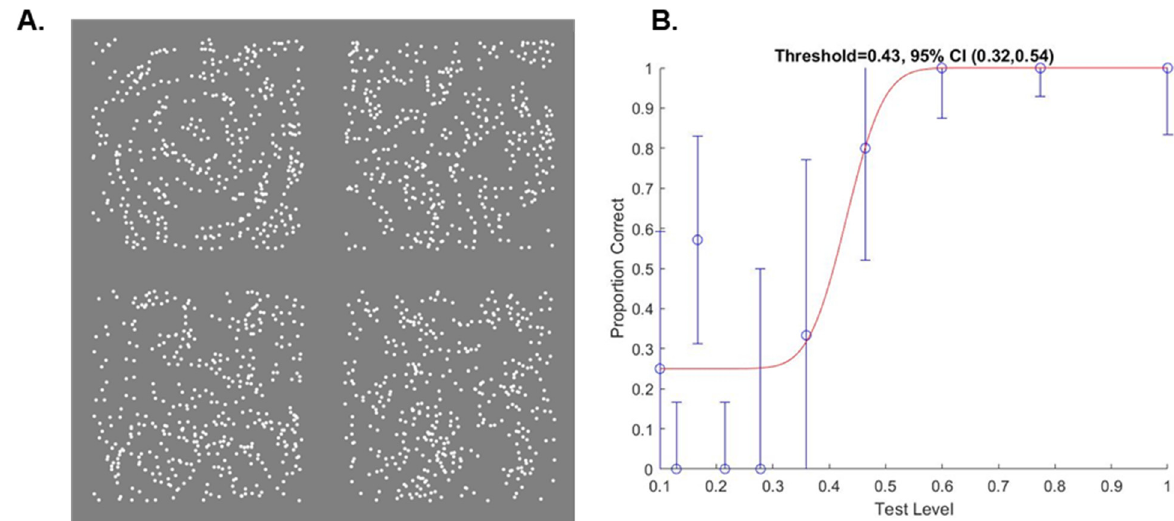
Figure 2. Example stimulus and psychometric function from the glass pattern task. ( A ) Each stimulus contained four quadrants, each of which contained 200 dipoles. The orientation of signal dipoles formed a global circular glass pattern (top left quadrant), and the orientation of noise dipoles was random. One of the 4 quadrants (at random across trials) contained a proportion (1.0 in this example) of signal and noise dipoles, and the remaining 3 quadrants contained only noise dipoles. Participants identified, using mouse click or screen touch, which of the 4 quadrants contained the circular pattern, guessing if necessary. ( B ) Typical psychometric function for one participant with CVI. The x axis shows the signal coherence (proportion of signal elements in the target quadrant), and the y axis shows the proportion of trials whereby the participant correctly identified the target quadrant. Circles show the proportion correct trials, error bars show the binomial standard deviation, and the red line shows the best fitting cumulative Gaussian function from which threshold and lower and upper 95% confidence intervals were estimated, shown in the title.